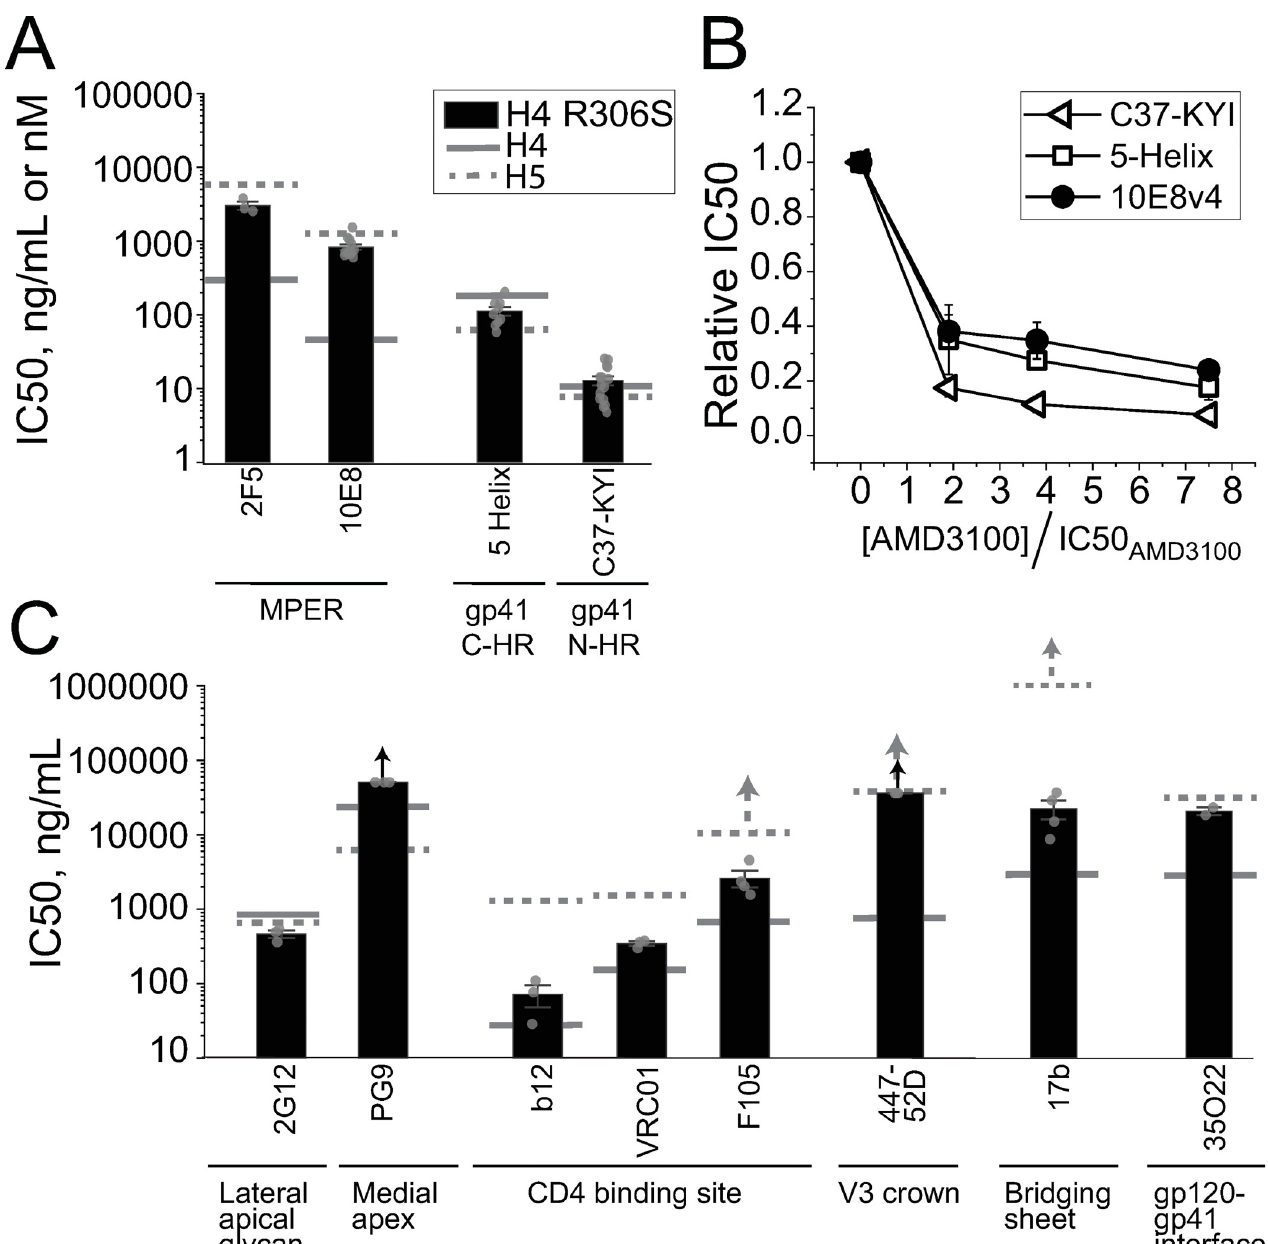
Fig 6. H4 R306S Env has an antibody sensitivity profile distinct from both wild type H4 Env and the chimeric H5 Env. ( A ) Anti-MPER antibody (2F5, 10E8) and FI (5-Helix, C37-KYI) neutralization potencies against H4 R306S Env. The solid and dashed gray lines reflect the average IC50 values obtained for H4 and H5 Envs, respectively. NAbs 2F5 and 10E8 were significantly less potent against H4 R306S Env than against wild type H4 Env; the antibody potencies against H4 R306S Env and H5 Env were not significantly different (one-way ANOVA with means comparison using the Tukey method, p < 0.025 for H4 / H4 R306S comparison [109]). ( B ) Impact of CoRA AMD3100 on the inhibitory potencies of C37-KYI (triangles), 5-Helix (squares) and NAb 10E8v4 (circles) against HIV-1 pseudotyped with H4 R306S Env. Data are normalized to the IC50 values obtained in the absence of CoRA. Note that CoRA concentration is expressed relative to the AMD3100 IC50 for H4 R306S Env (53 nM). The data sets for 5-Helix and 10E8v4 are not statistically different as assessed by two-way ANOVA (p = 0.9); the difference in data sets for C37-KYI and 10E8v4 does achieve significance (p = 0.022). ( C ) Anti-gp120 and anti-interface antibody neutralization potencies against H4 R306S Env. Arrows above the bars and dotted lines indicate that 50% neutralization was not achieved for H4 R306S and H5 Envs at the highest concentrations tested. Of these antibodies, only NAbs 447-52D, 35O22 and PG9 had significantly lower potencies in comparisons of H4 R306S and H4 Env (one-way ANOVA with means comparison using the Tukey method, p < 0.025). All data reflect the mean ± SEM of three or more independent experiments.